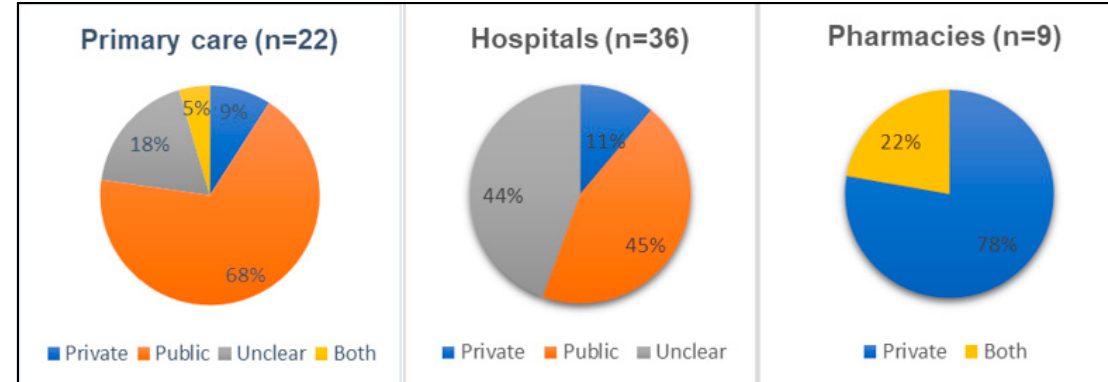
Figure 1. Sector where intervention was tested, by type of health setting.